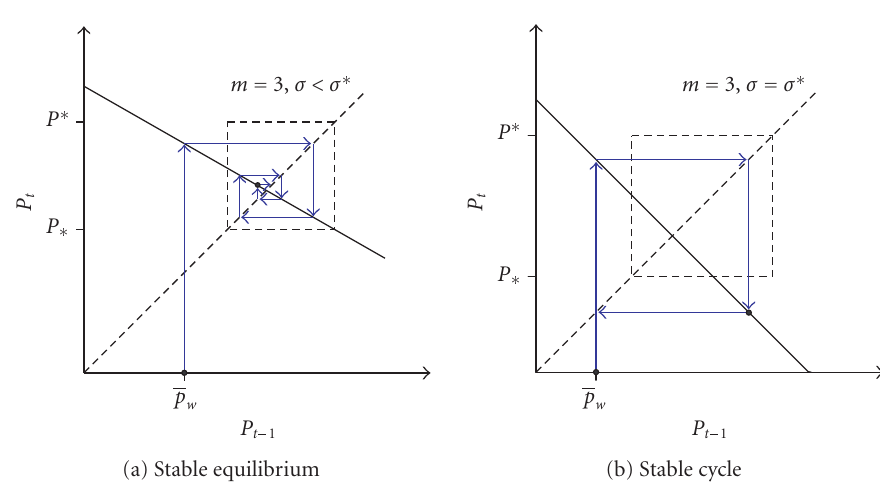
Figure 4.3. Transitionary dynamics: starting with all